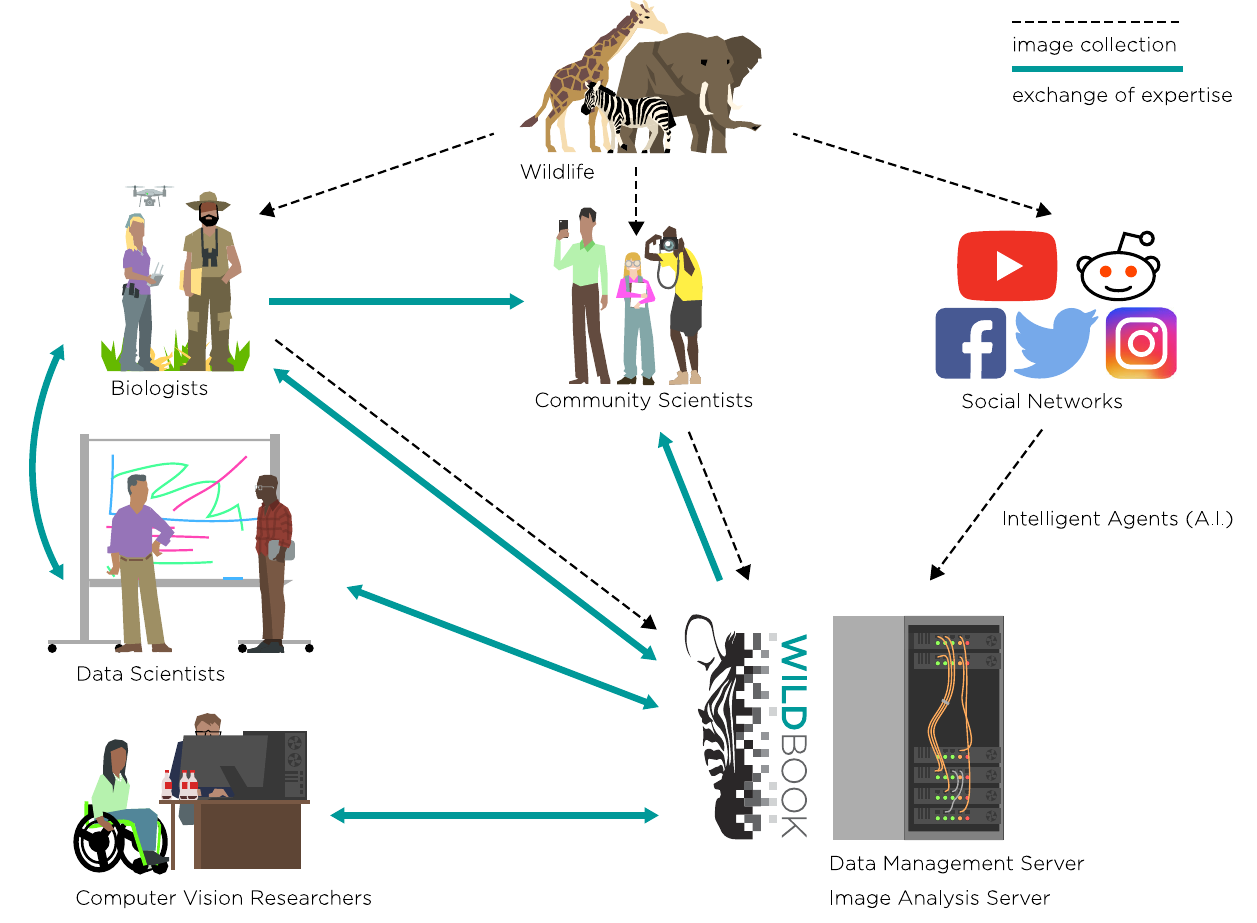
Fig. 4 The Wildbook Ecosystem. Wildbook allows scientists and wildlife managers to leverage the power of communities and ML to monitor wildlife populations. Images of target species are collected via research projects, community science events (e.g., the Great Grevy ’ s Rally; see text), or by scraping social media platforms using Wildbook AI tools. Wildbook software uses computer vision technology to process the images, yielding species and individual identities for the photographed animals. This information is stored in databases on Wildbook data management servers. The data and biological insights generated by Wildbook facilitates exchange of expertise between biologists, data scientists, and stakeholder communities around the